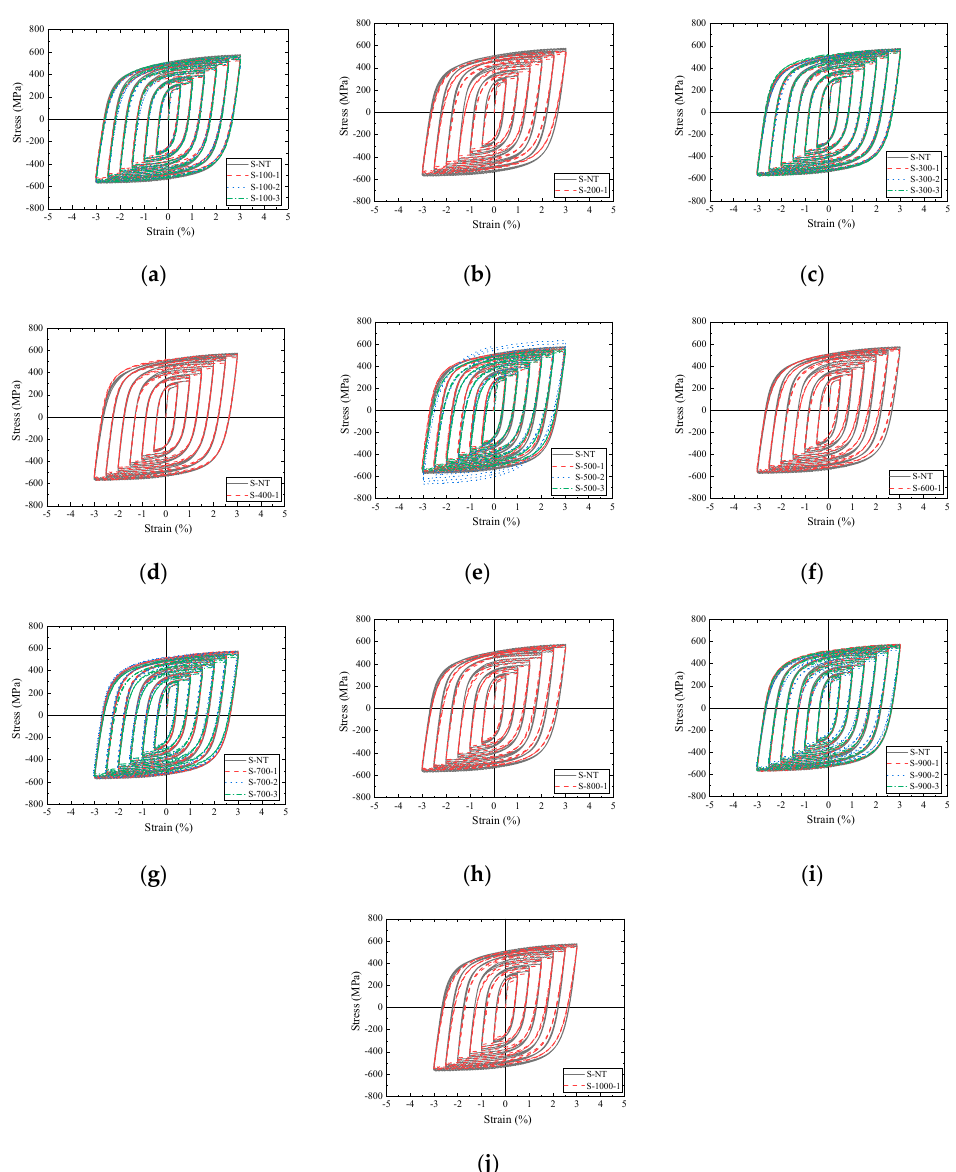
Figure 14. Hysteretic curves of S316. ( a ) 100 °C; ( b ) 200 °C; ( c ) 300 °C; ( d ) 400 °C; ( e ) 500 °C; ( f ) 600 °C; ( g ) 700 °C; ( h ) 800 °C; ( i ) 900 °C; ( j ) 1000 °C.